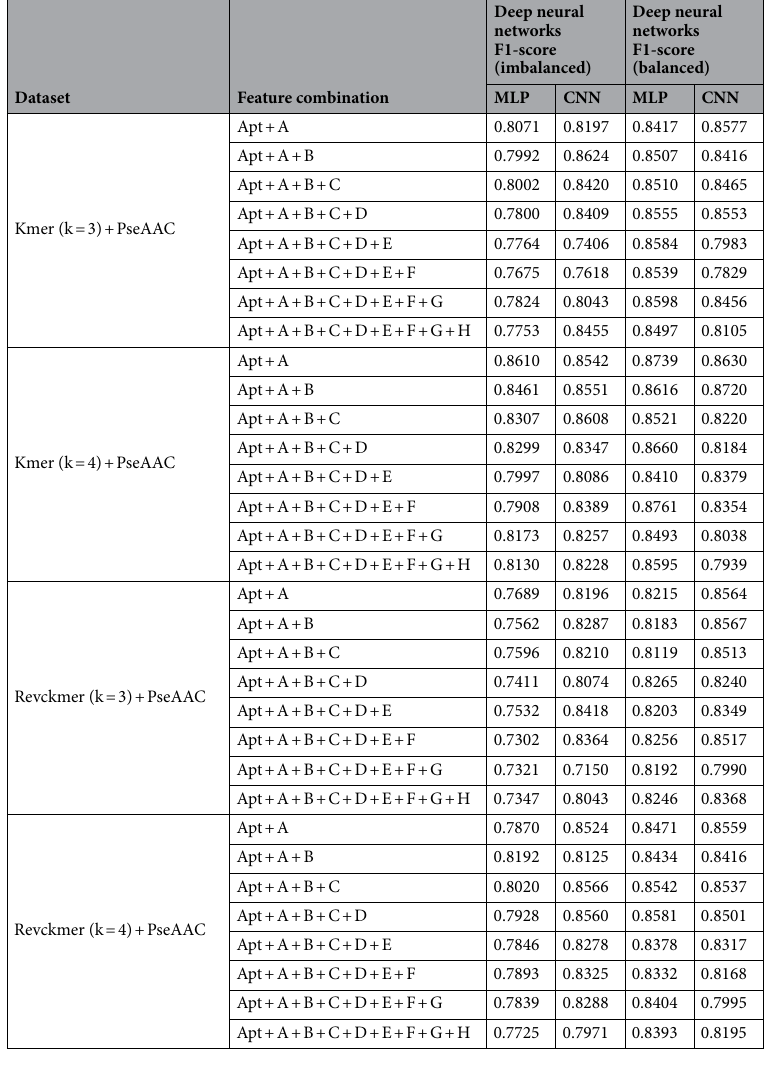
Table 2. The average performances of two deep neural network classifiers on 32 different datasets, with and without the balancing method. Where Kmer 3 is 3mer frequency, Kmer 4 is 4mer frequency, Revckmer 3 is reverse complement 3mer, and Revckmer frequency 4 is reverse complement 4mer frequency for apt, which represents aptamer properties. For protein properties: A indicates hydrophobicity, hydrophilicity, and mass; B indicates polarity, molecular weight, and melting point; C indicates transfer free energy, buriability, and bulkiness; D indicates solvation free energy, relative mutability, and residue volume; E indicates volume, amino acid distribution, and hydration number; F indicates isoelectric point, compressibility, and chromatographic index; G indicates unfolding entropy change, unfolding enthalpy and unfolding Gibbs free energy change; H indicates power to beat the N terminal, C terminal, and middle of the alpha helix. MLP multi-layer perceptron; CNN convolutional neural